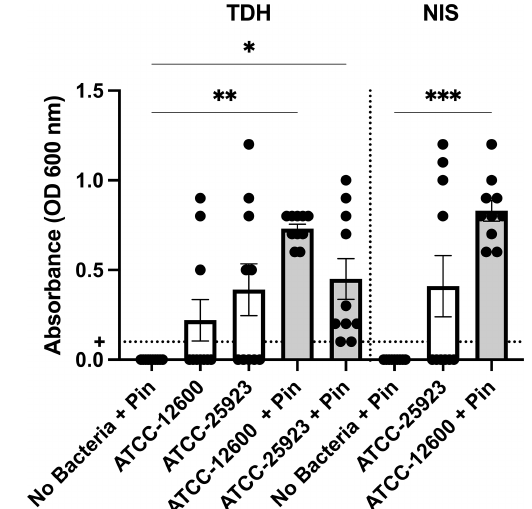
Figure 4. Study 2. The optical density (600nm absorbance) read- ings following culture from bone swabs are shown as a surrogate measure of bacterial load. For the purposes of determining “in- fection” positivity or negativity, a cutoff of 0.1 was used. Signifi- cantly higher readings were seen with ATCC 12600 and a pin in the TDH and NIS models. The p values are as displayed as follows: ∗